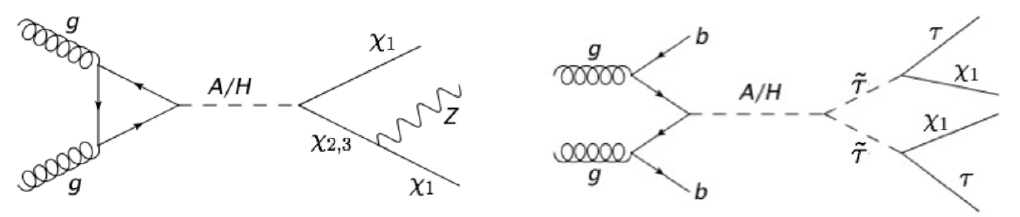
Figure 1 . Feynman diagrams for the two signal topologies we study in detail in this paper. Left panel : gluon fusion production of heavy Higgs bosons, which decay to neutralinos, yielding a Z + =E T signal. Right panel : b-associated production followed by decay to staus, giving a 2 b +2 (cid:28) + =E T